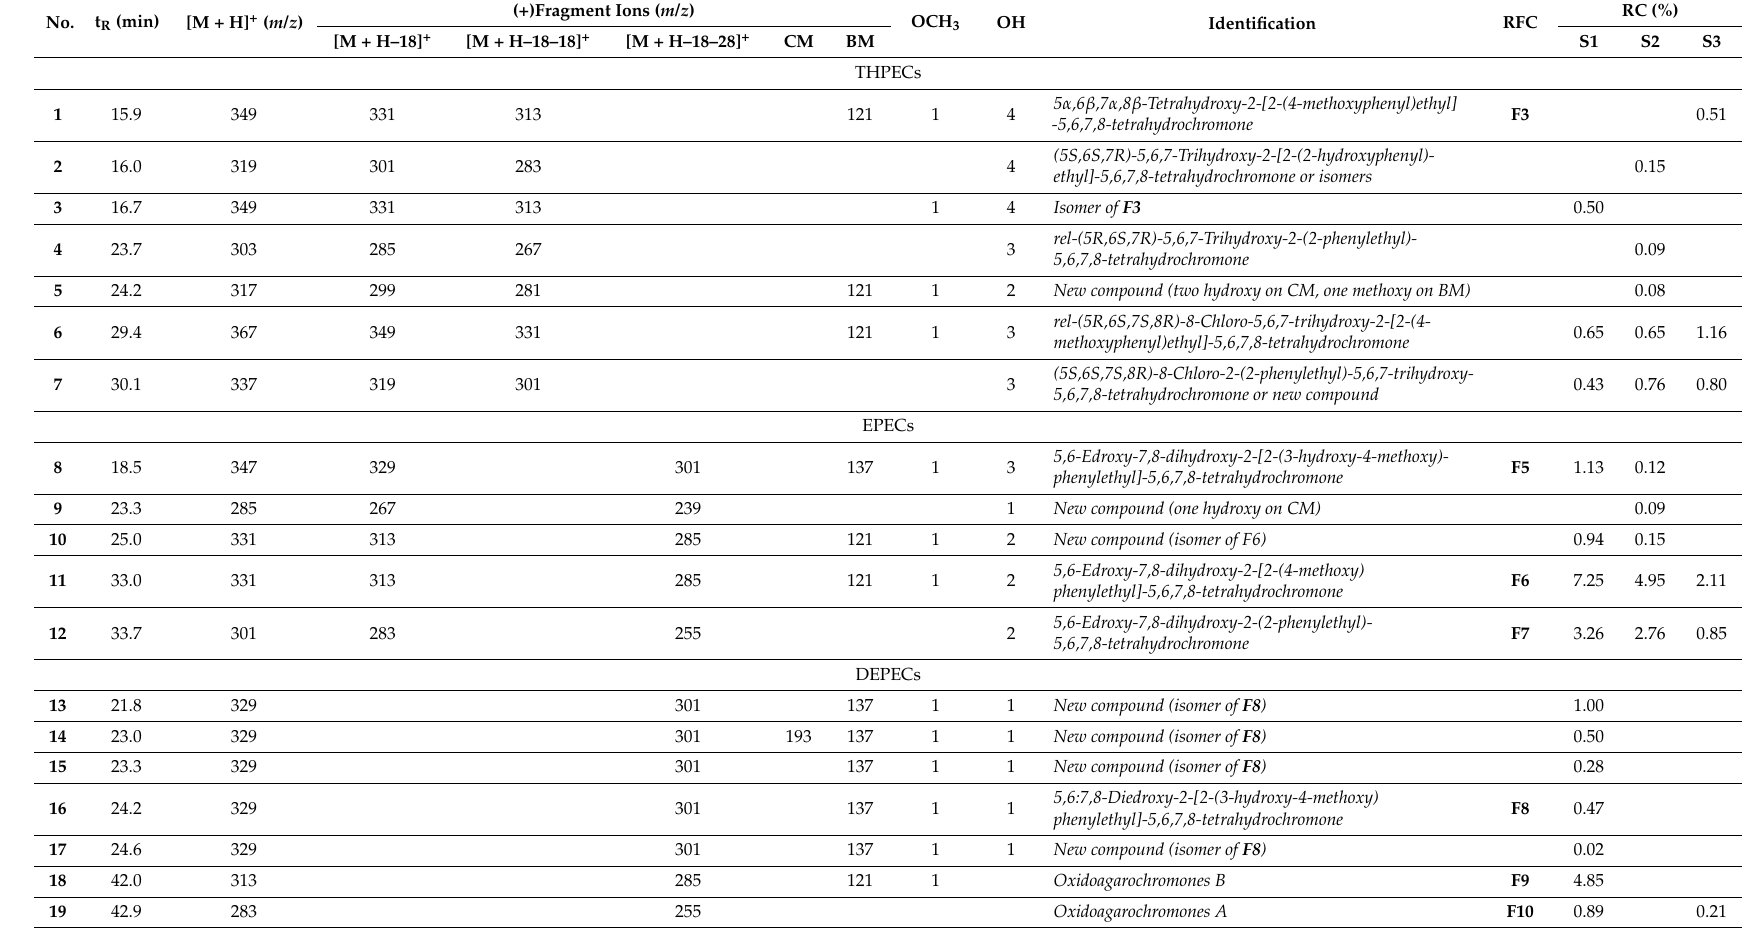
Table 2. The MS characterization and identified or characterized results of DEPECs, EPECs and THPECs from S1 to